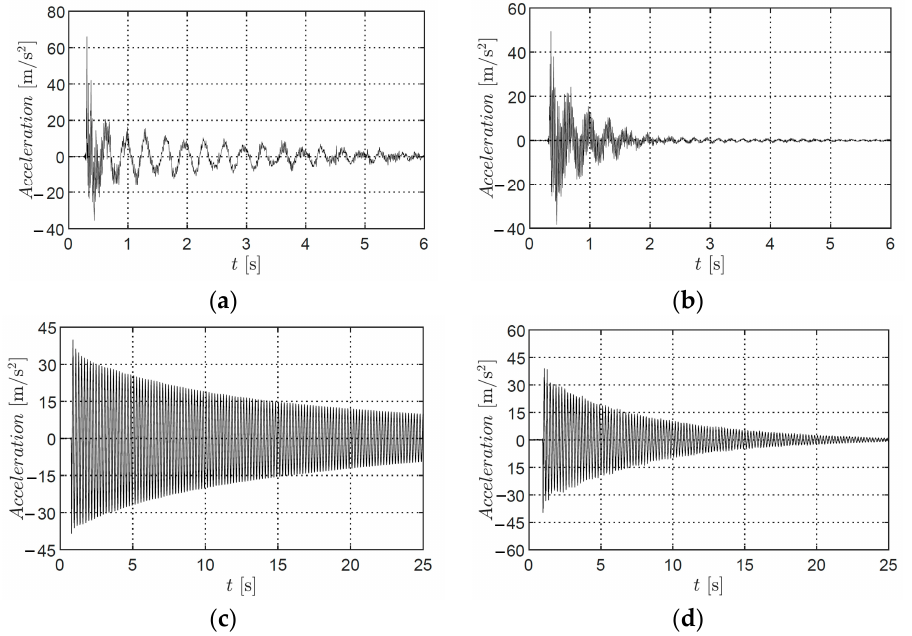
Figure 15. Dominant coupled response from Setup 1: ( a ) vertical at U = 0 m/s; ( b ) vertical at U = 10 m/s; ( c ) torsional at U = 0 m/s; ( d ) torsional at U = 10 m/s.